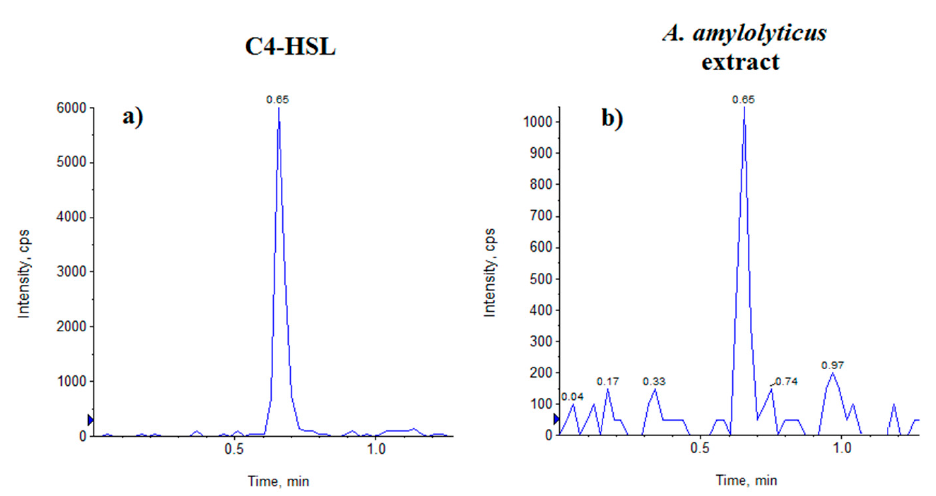
Figure 1. Representative LC-MRM ( m / z 172 > 102) chromatograms of a ) N -butanoyl-homoserine Figure 1 . Representative LC ‐ MRM ( m/z 172 > 102) chromatograms of a ) N ‐ butanoyl ‐ homoserine lactone (C4-HSL) standard and b ) Anoxybacillus amylolyticus lactone (C4 ‐ HSL) standard and b ) Anoxybacillus amylolyticus extract.